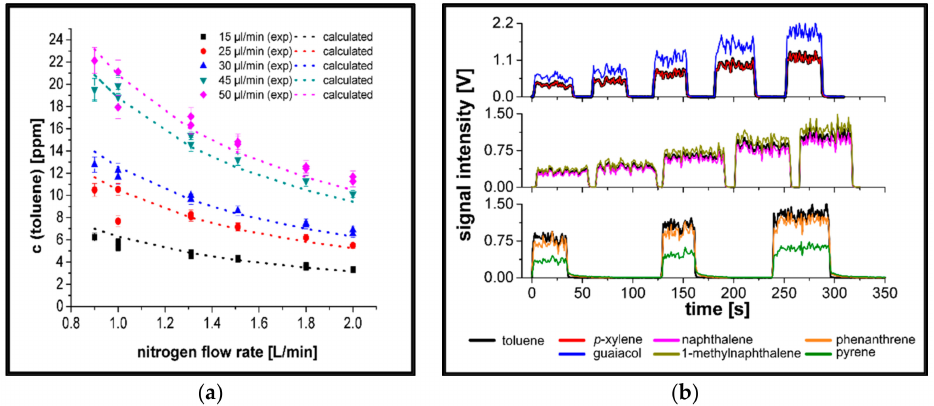
Figure 3. Evaluation of the sample inlet system. ( a ) Comparison of theoretical (calculation based on Equation (6); dotted lines) and experimental (symbols) toluene concentrations for different sample flow rates as a function of nitrogen flux. ( b ) Signal response and stability for selected single-core aromatics and polycyclic aromatic hydrocarbons (PAHs) at different sample flow rates.